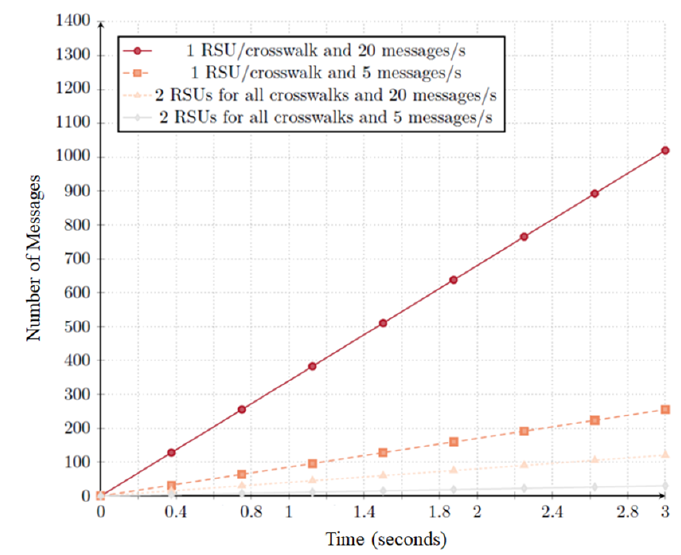
Figure 12. Number of messages sent by Road Side Units (RSU) per second.